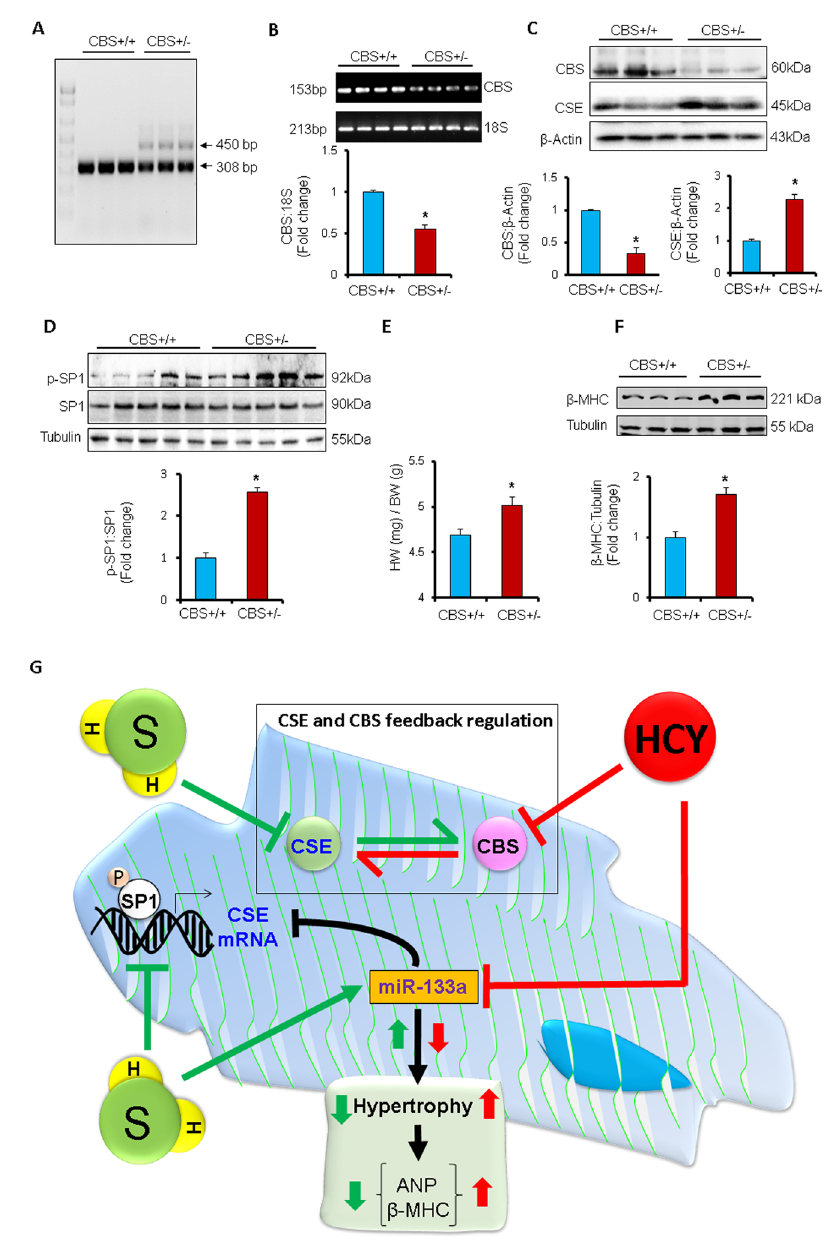
Figure 8. Deficiency of CBS upregulates CSE by inducing SP1. ( A ) Genotyping for CBS + / − and CBS + / + mice. Representative agarose gel electrophoresis showing PCR bands of CBS + / − and CBS + / + mice. CBS heterozygous (CBS + / − ) mice have two bands whereas CBS homozygous (CBS + / + ) mice have single band. N = 3. ( B ) RT-PCR showing cardiac levels of CBS in CBS + / − and CBS + / + mice. 18 S is an endogenous control. N = 4. ( C ) Western blot showing cardiac levels of CBS and CSE in CBS + / + and CBS + / − mice. N = 5. ( D ) Western blot showing the activity of SP1 (p-SP1: SP1) in the heart of CBS + / + and CBS + / − mice. N = 5. Values are represented as mean ± SEM. p < 0.05 is considered statistically significant. ( E ) Bar graph showing heart to body weight ratio in CBS + / + and CBS + / − mice ( p = 0.01). ( F ) Western blot showing the cardiac expression of β -myosin heavy chain ( β -MHC), a molecular marker for cardiac hypertrophy, in CBS + / + , and CBS + / − mice. N = 5. Values are represented as mean ± SEM. p < 0.05 is considered statistically significant. “ * ” Represents statistically significant values when compared to the CBS + / + control. ( G ) Schematic representation showing the negative feedback regulation of CBS and CSE, and impact of homocysteine (Hcy) or hydrogen sulfide (H 2 S) on this feedback regulation. Hcy downregulates CBS and miR-133a. Reduced levels of miR-133a induces cardiac hypertrophy, which is reflected by increased levels of atrial natriuretic peptide (ANP) and beta- myosin heavy chain ( β -MHC), the molecular markers for cardiac hypertrophy. H 2 S inhibits hypertrophy by inducing miR-133a. MiR-133a also targets SP1, an inducer of CSE. Therefore, H 2 S indirectly downregulates SP1 by upregulating miR-133a. H 2 S also inhibits CSE directly by suppressing the activity of